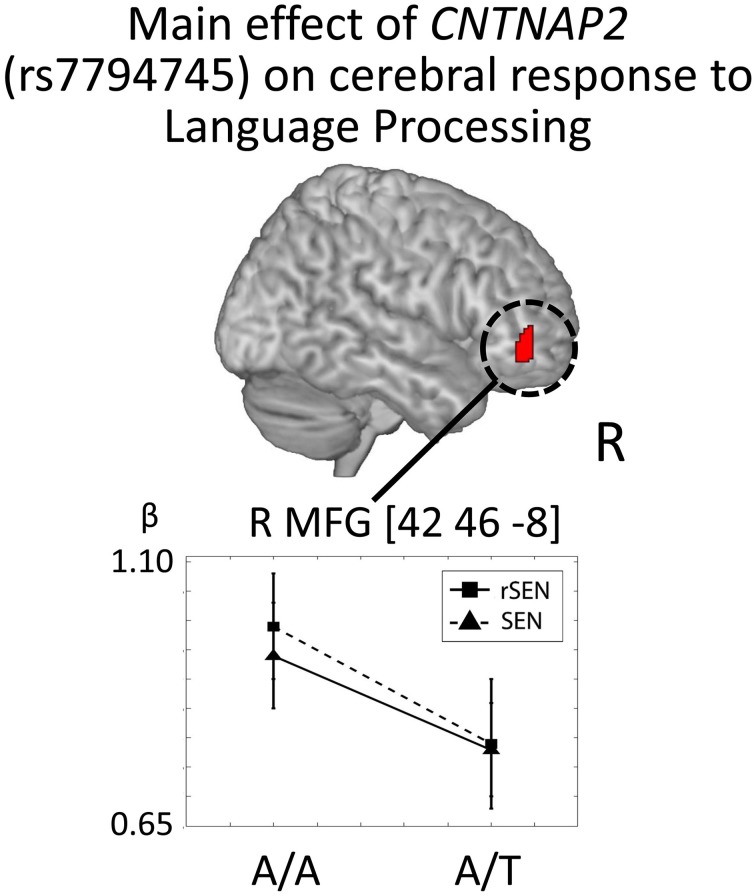
CNTNAP2 (rs7794745) effect on cerebral response to language processing. The results of the main effect of rs7794745 (A/A or A/T) in the analysis of full factorial design are shown. The error bar shows the distribution of beta values of cerebral activation under rSEN minus baseline (mean: black squares; dashed line) and under SEN minus baseline (mean: black triangles; line) at the peak coordinates with the main effect of rs7794745 (A/A or A/T). Significant difference was observed in right MFG. Abbreviations: R, right hemisphere; MFG, middle frontal gyrus.